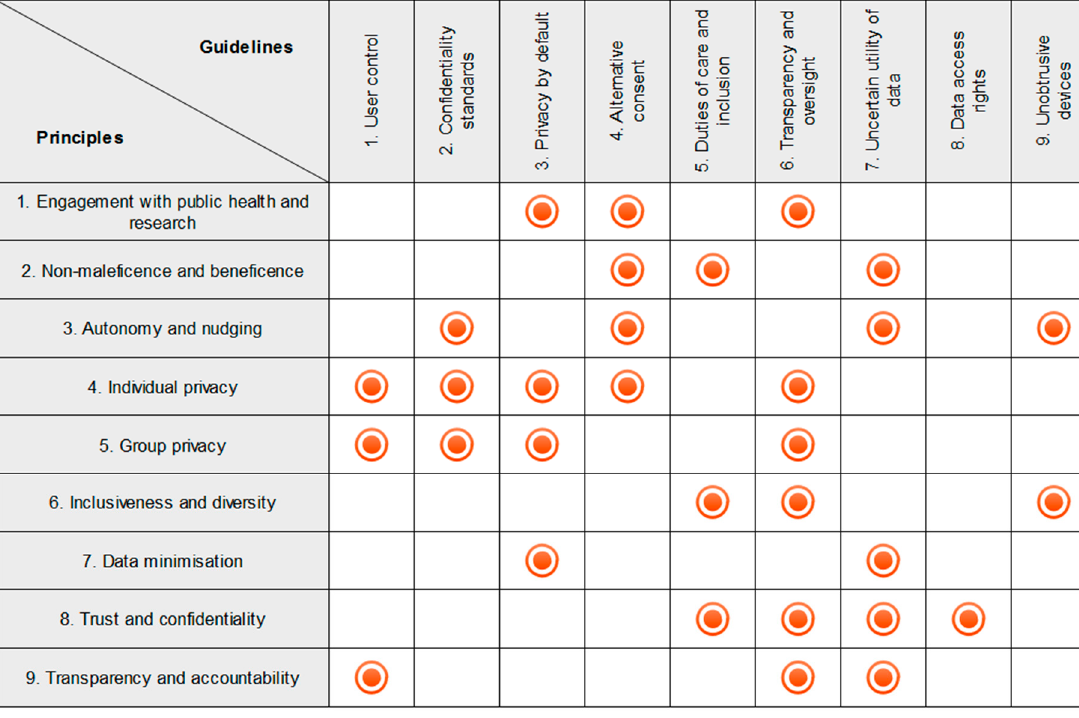
Figure 1. Relationship between Principles and Guidelines.